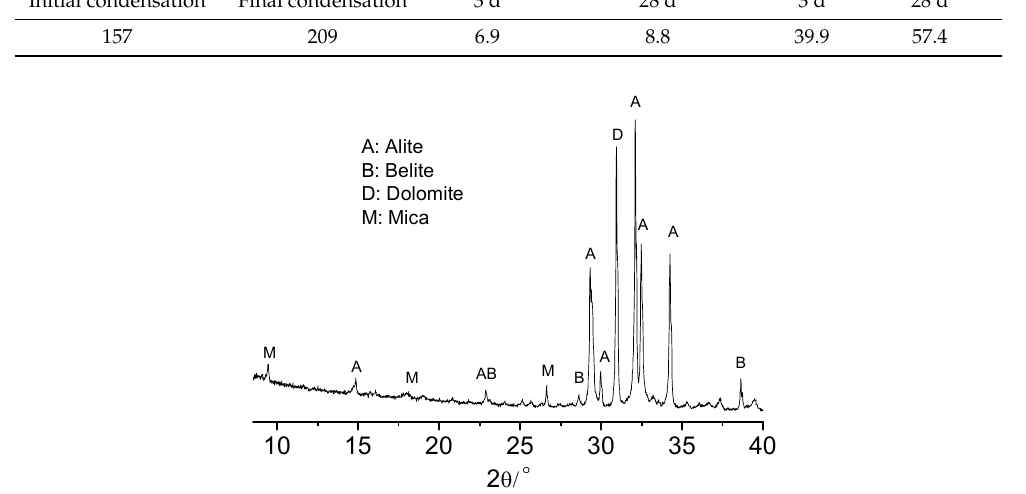
Figure 1. XRD diagram of the white cement.